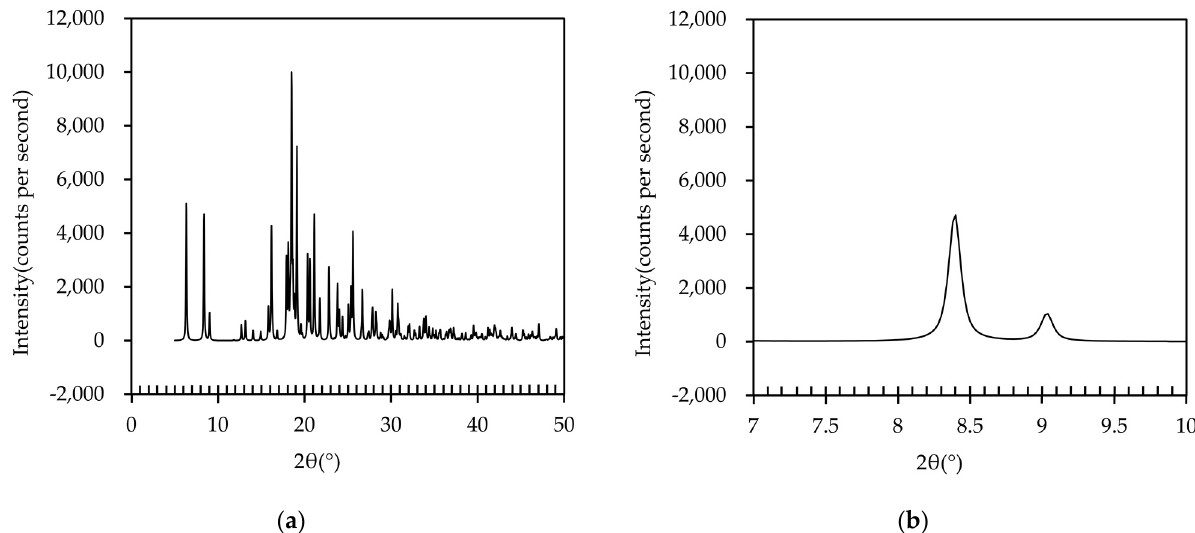
Figure 9. ( a ) PXRD pattern of IBP–TXA salt; ( b ) PXRD peak of IBP–TXA salt near 8.5°.